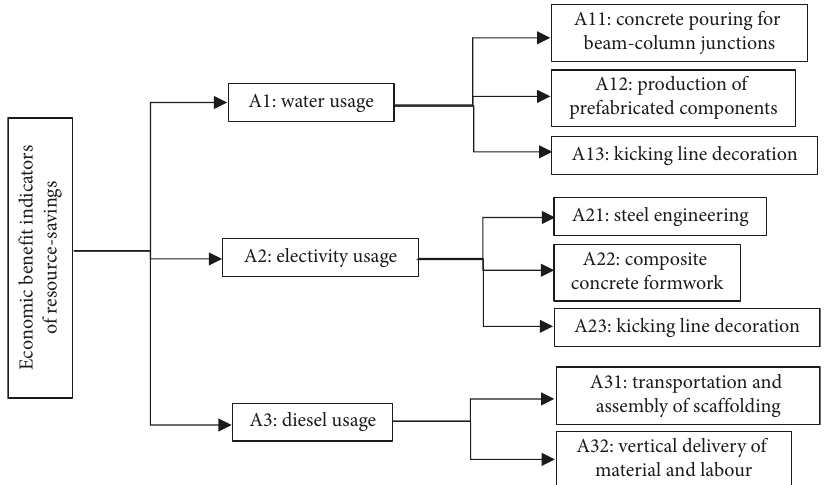
Figure 1: Economic benefits of resource-savings in prefabricated construction.